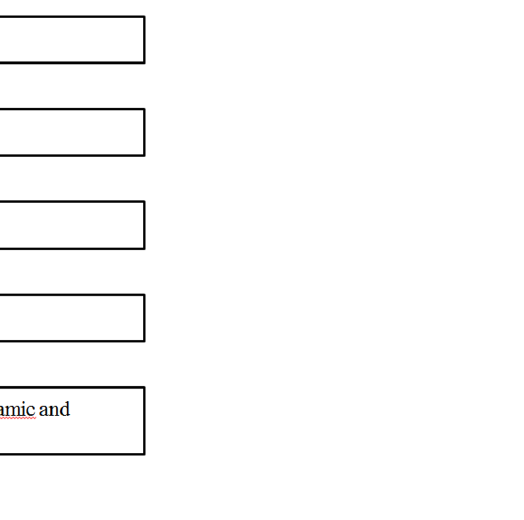
Participants included 9 male patients and 1 female patient with an age of 65.8 ¡ 9.3 (mean ¡ SD) years, body weight of 57.9 ¡ 9.8 kg, and body mass index (BMI) of 21.4 ¡ 2.6 kg/m 2 . The duration of diabetes was 20.1 ¡ 9.0 years. The baseline HbA and GA were 5.9 ¡ 0.9% and 21.0 ¡ 2.8%, respectively. The 1c diabetic patients with ESRD in this trial had high levels of creatinine (11.4 ¡ 2.5 mg/dL) and blood urea nitrogen (BUN, 62.4 ¡ 16.9 mg/dL), and a reduced estimated GFR (eGFR, 4.2 ¡ 1.3 mL/min/1.73 m 2 ). The total cholesterol,